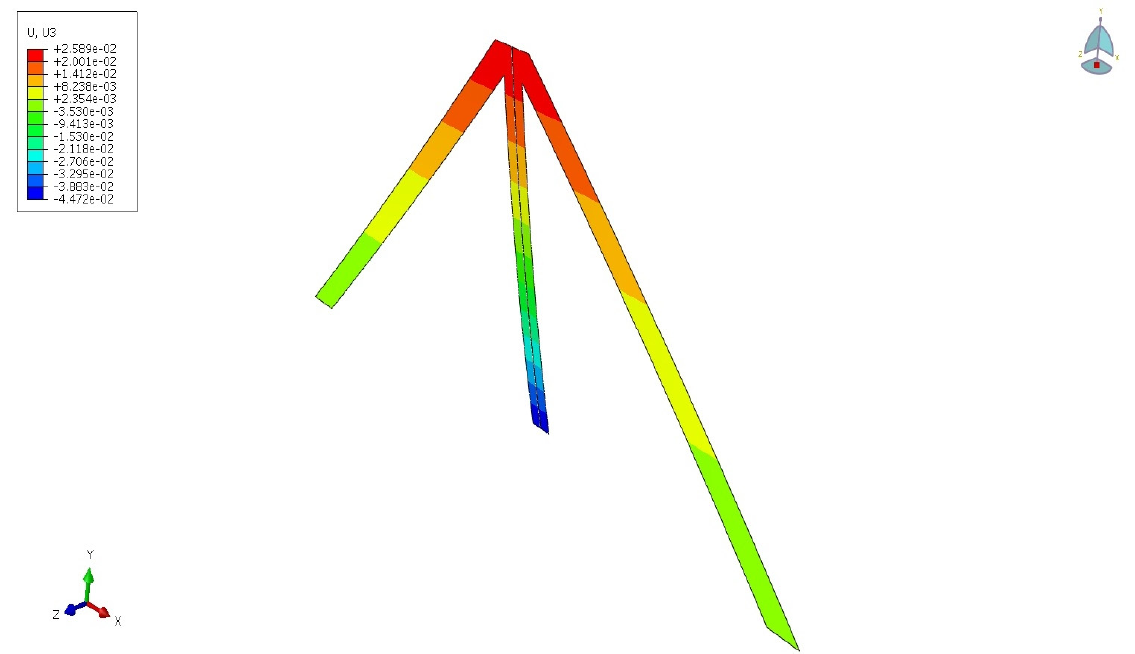
Figure 2. Deflection profile for assembly (c) using numerical solutions with L = 385 μ m, in μ